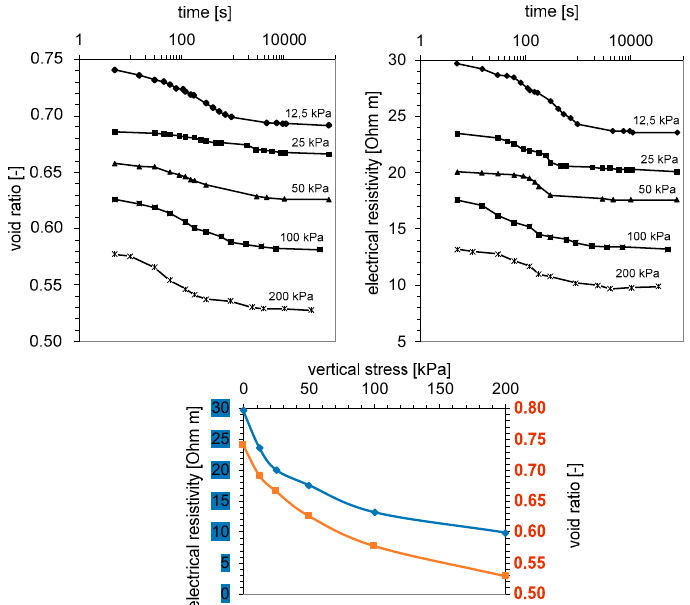
Figure 8. Changes in the void ratio and electrical resistivity during loading cycles of sandy clay (sisaCl) samples taken from the SGGW Campus in a modified oedometer.